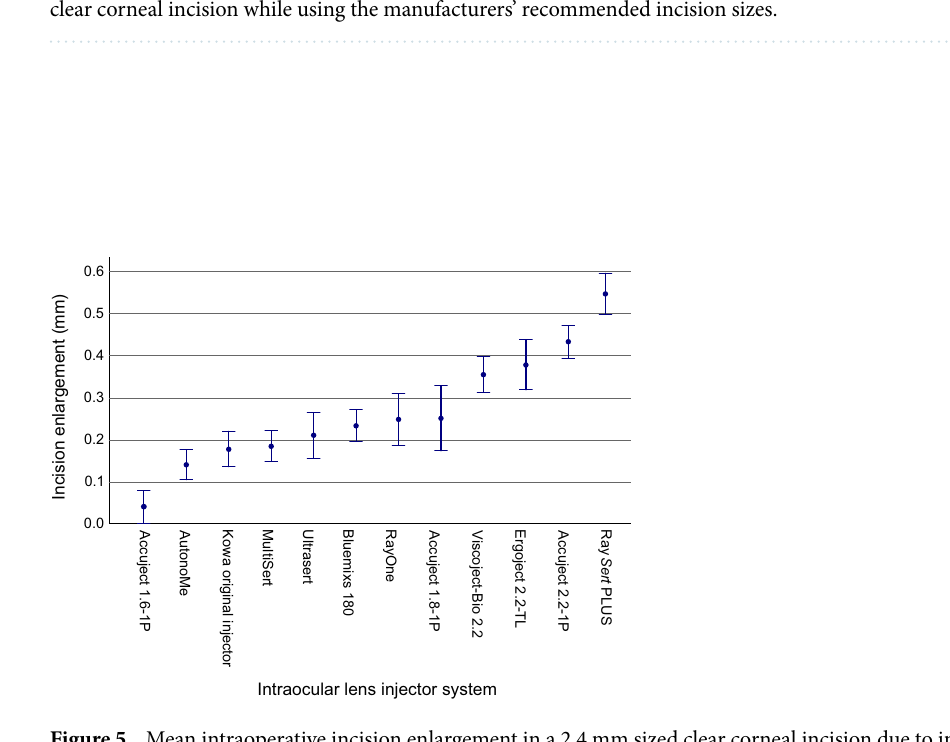
Figure 4. Frequency of intraoperative incision enlargement due to intraocular lens injector insertion into a clear corneal incision while using the manufacturers’ recommended incision sizes.